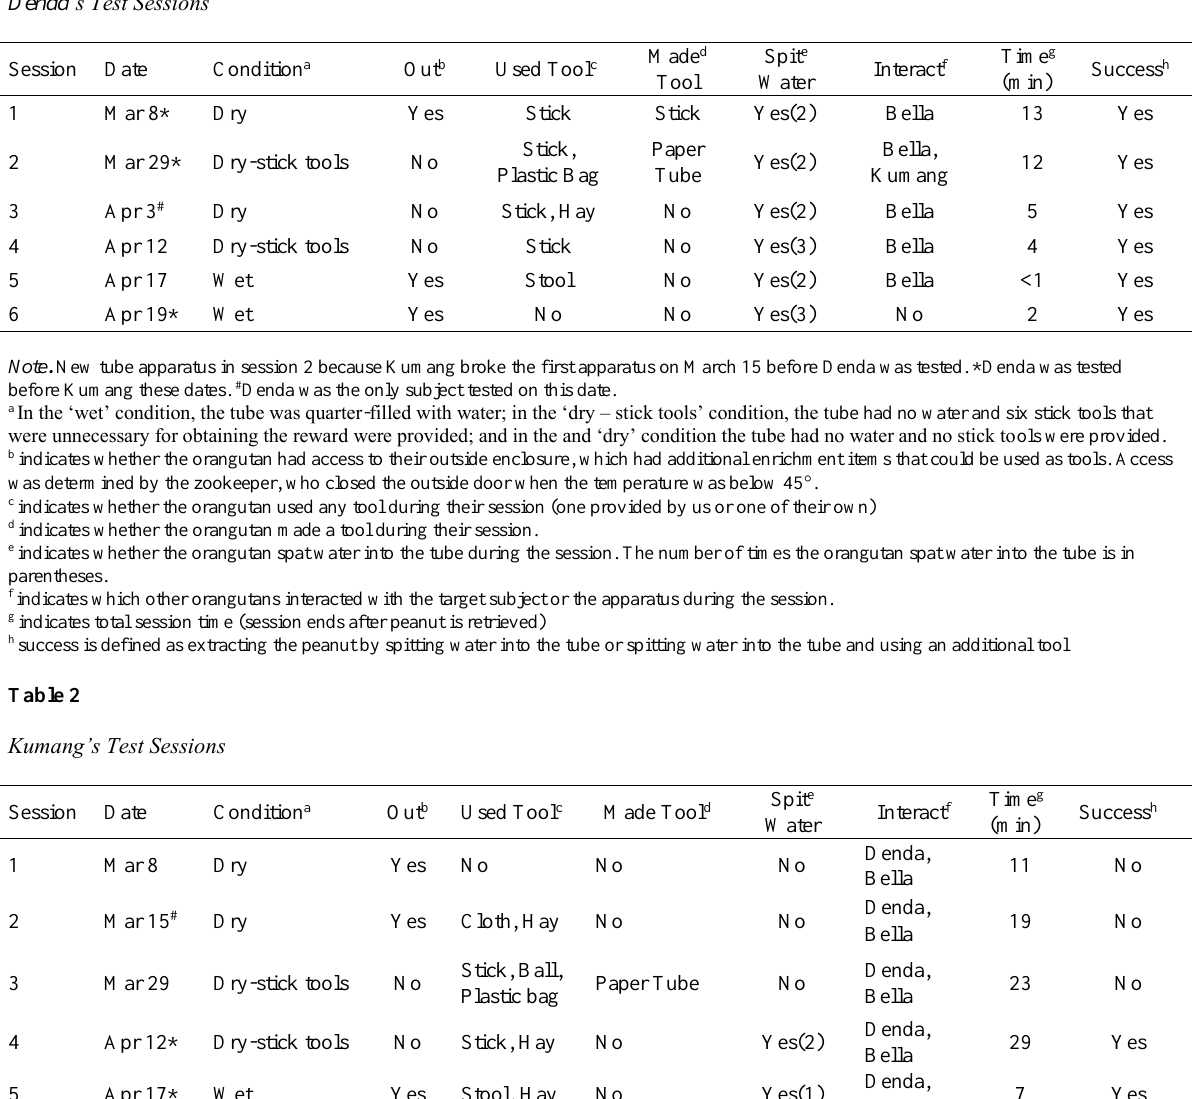
Denda’s Test Sessions